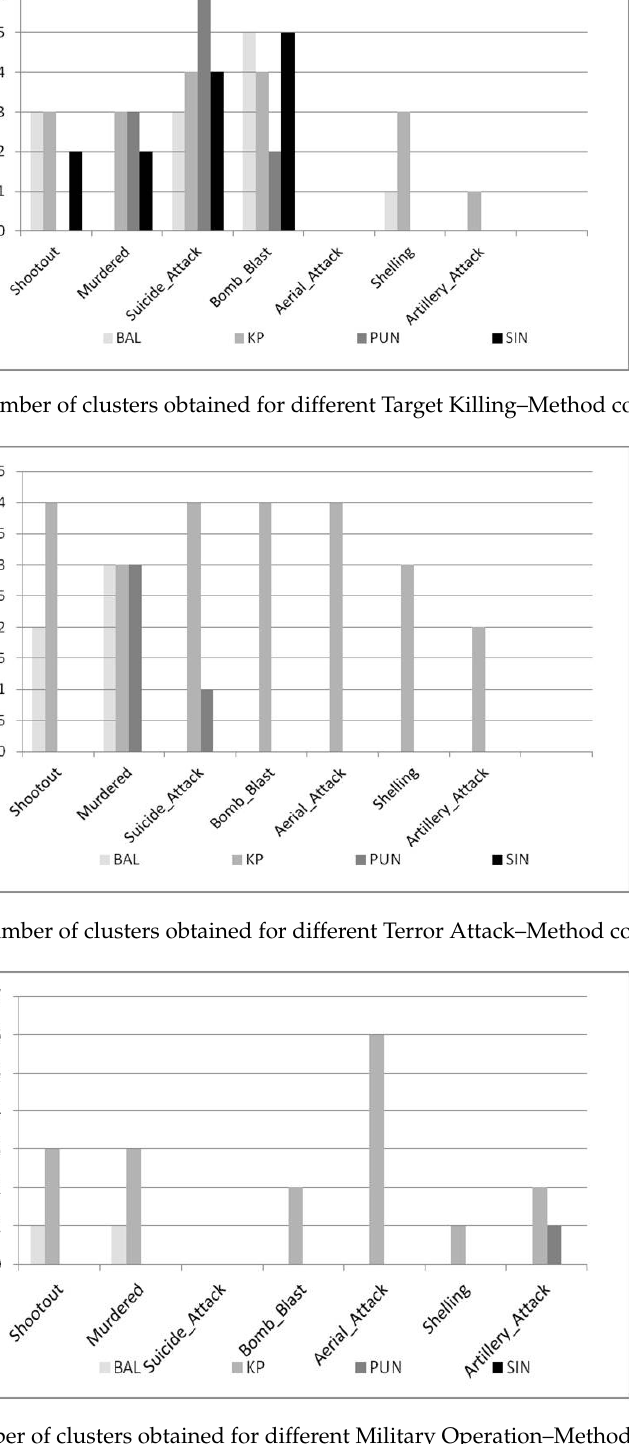
Figure 13. Number of clusters obtained for different Military Operation – Method combinations.